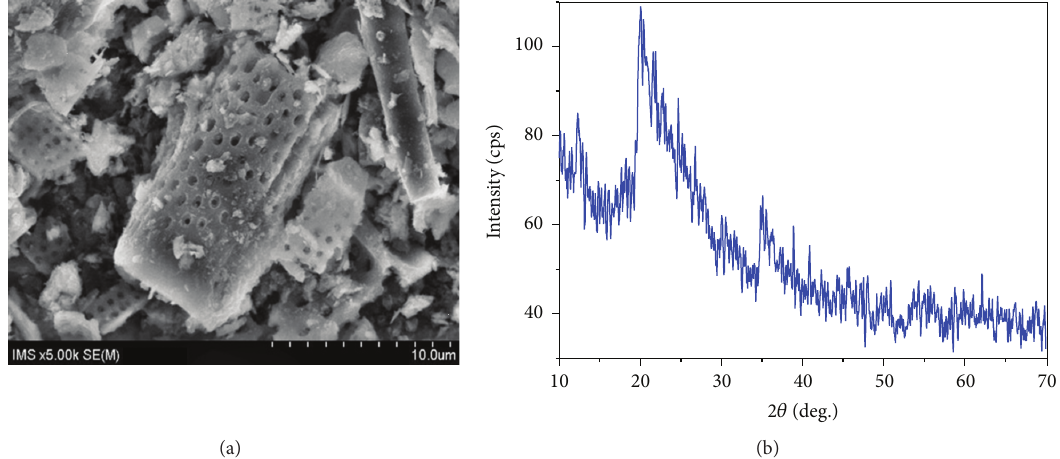
Figure 1: SEM observation (a) and PXRD pattern (b) of diatomite.